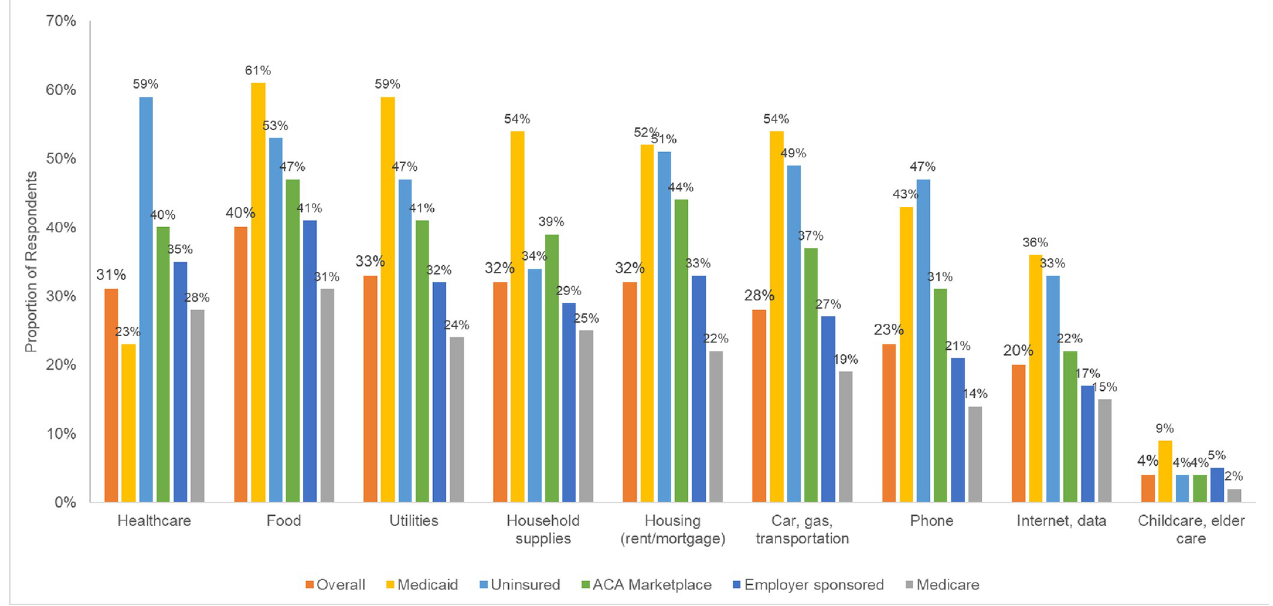
Fig 1. Proportion of respondents reporting trouble paying for healthcare and non-healthcare needs during the COVID-19 pandemic by health insurance status (N = 1437).